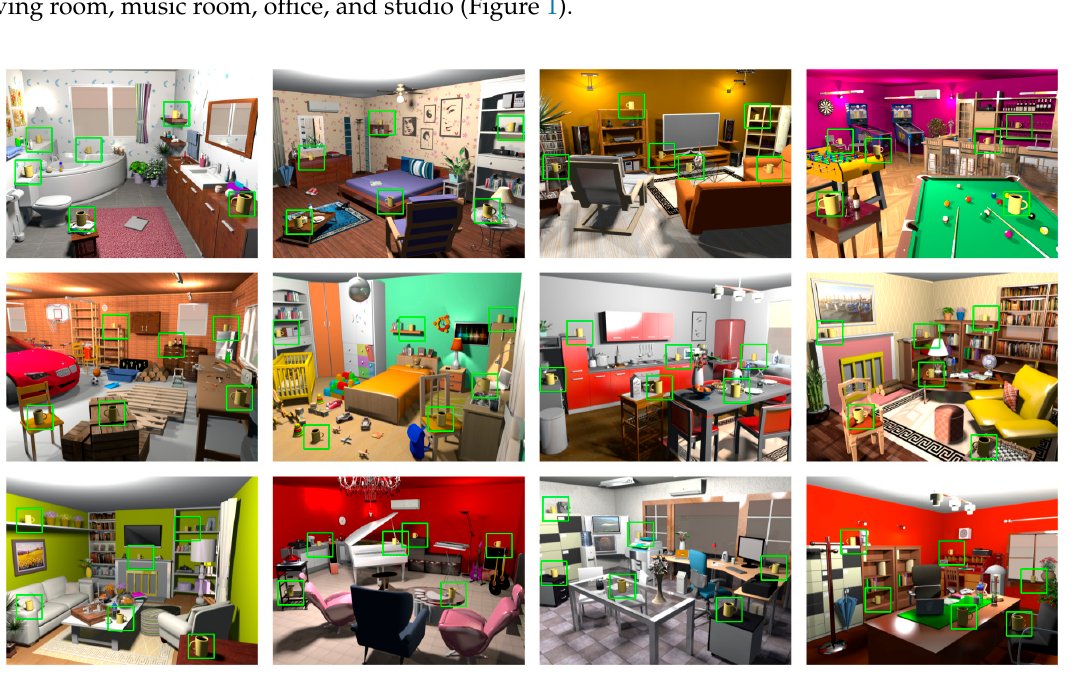
Figure 1. Interior scenes used in the experiment. The task was to search for the yellow mug and to indicate the left/right direction of the handle by an alternative forced choice response. For each scene, all six possible targets and their locations are shown. In the experiment, however, each scene contained only one target. In repeated displays, the target occurred at the same location across repetitions whereas in new displays, the target appeared once at each of the shown positions across repetitions. The green squares indicating target locations are for illustrative purposes and were not presented during the experiment.